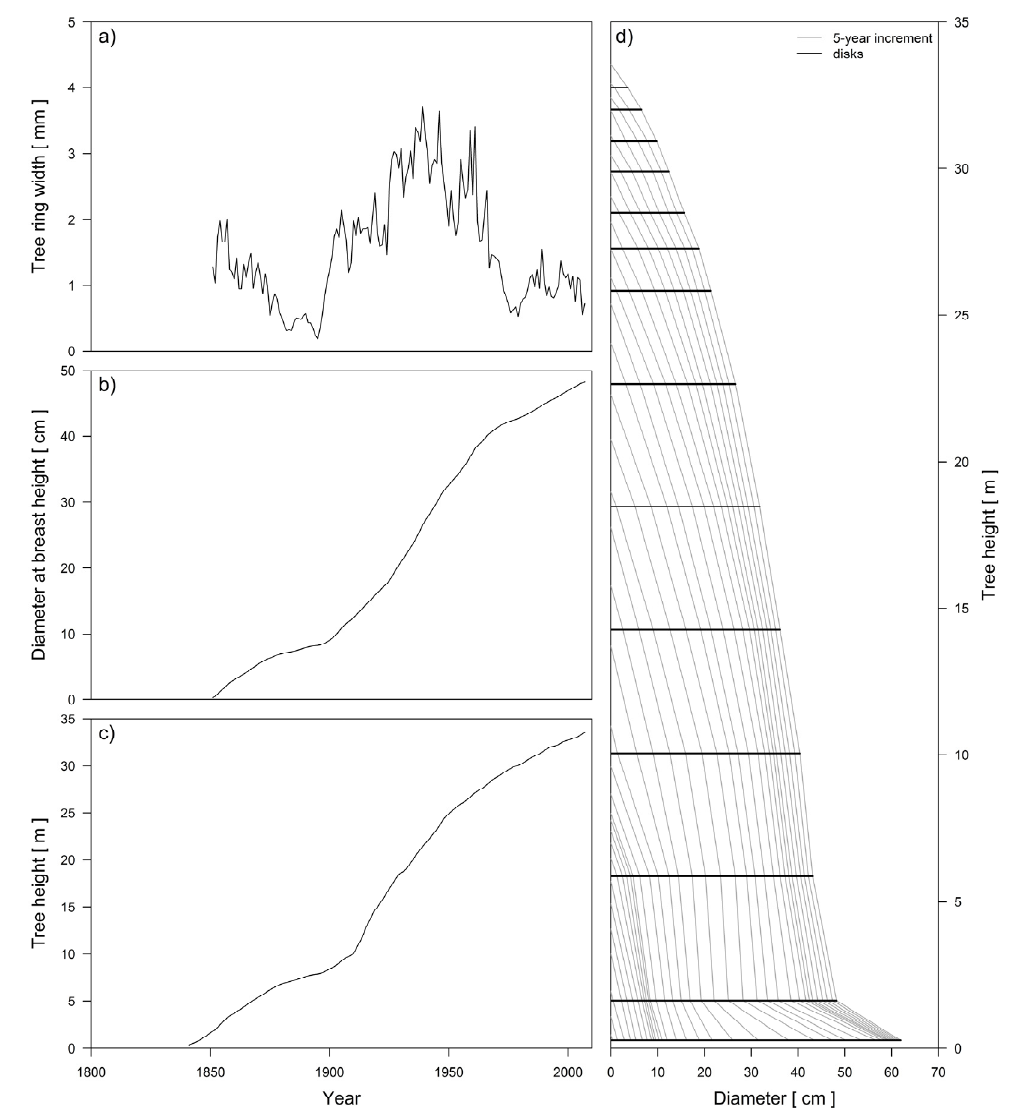
2 Figure 2. Example of the graphical output from the code for stem analysis, written in the R program- ing language. Top left: tree ring width series ( a ); middle left: diameter growth ( b ); bottom left: height growth increment ( c ); and right: stem analysis for selected silver fir with marked stem disks and 5-year increments ( d